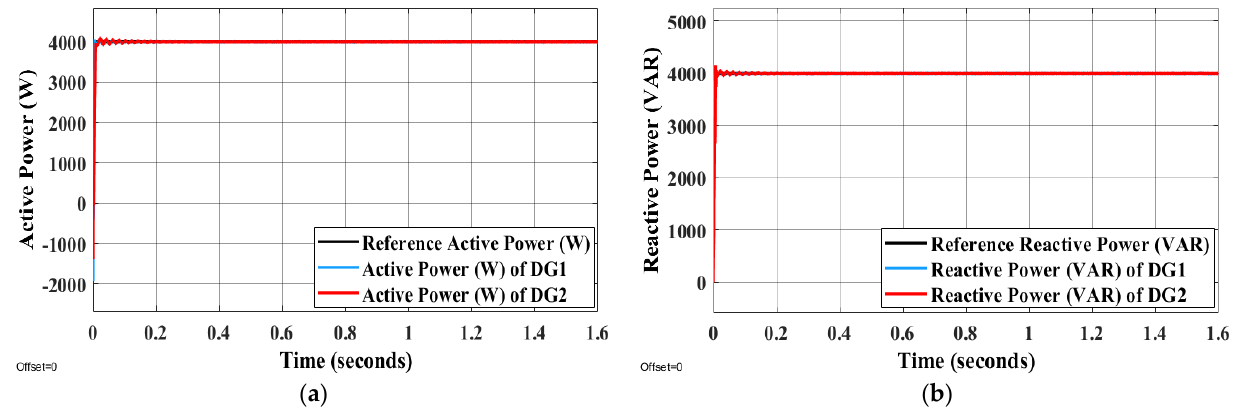
Figure 15. Individual DG power flow control using the proposed technique under changing load conditions: ( a ) active power and ( b ) reactive power.